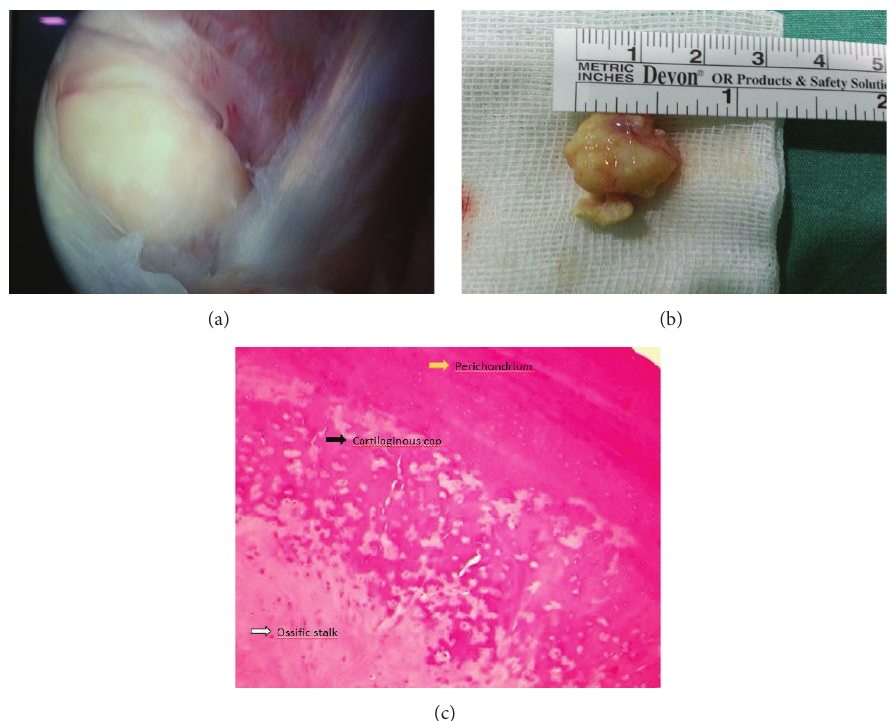
Figure 2: Before excision (a), after excision (b), and microscopical view (c) of